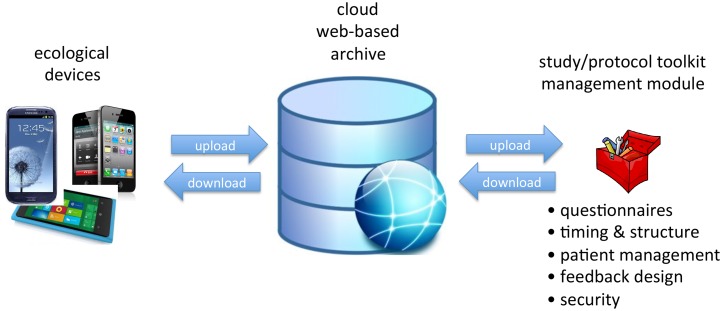
Principles of mROM.